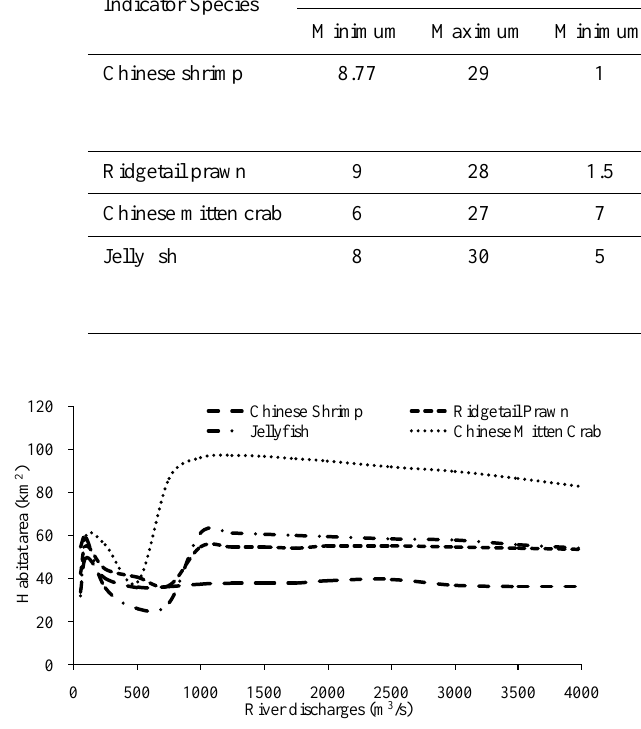
Fig. 3. Relationship between river discharge and habitat area for typical